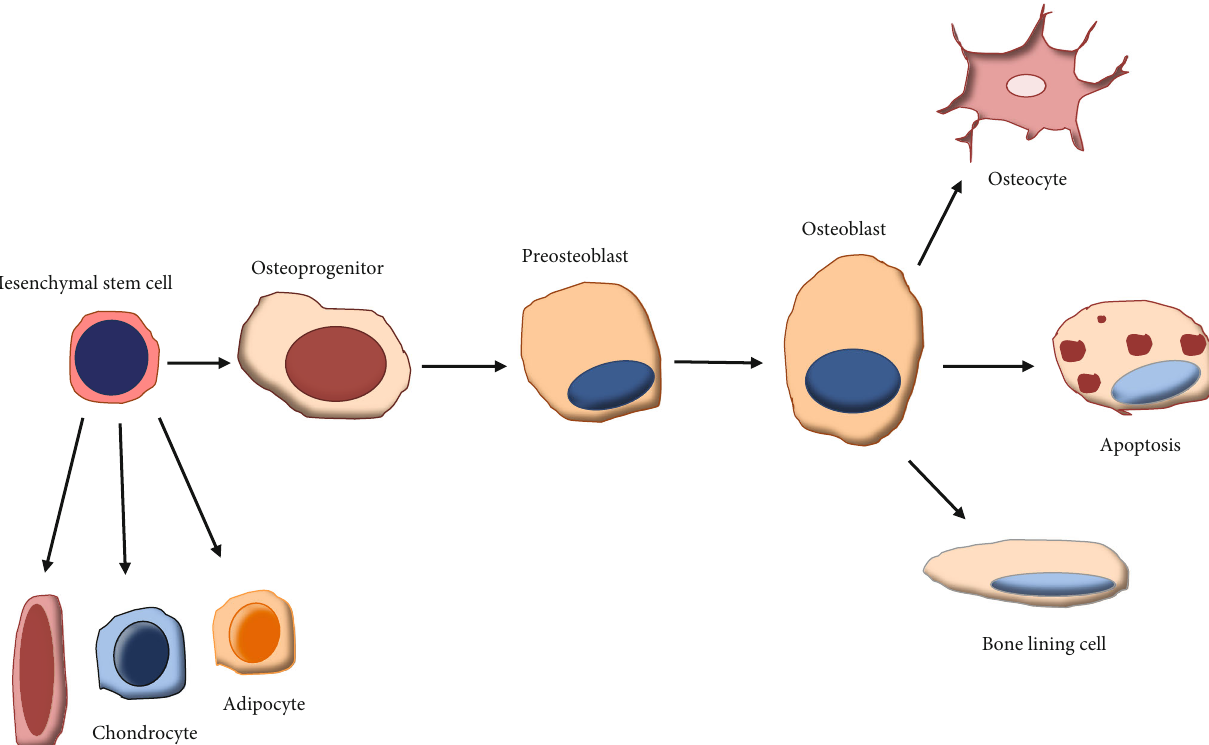
Figure 1: Osteogenic lineage. The process of osteogenic di ff erentiation of